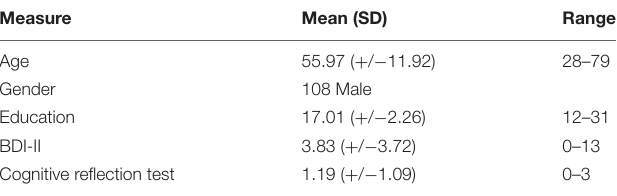
TABLE 1 | Demographic and test